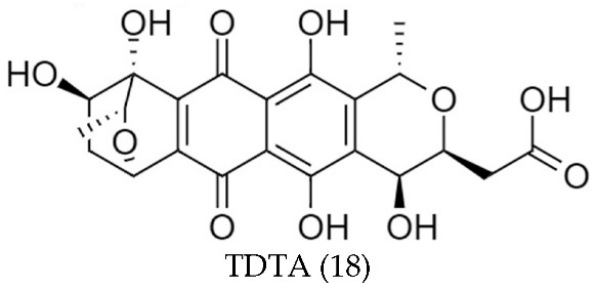
Figure 13. Chemical structures of TDTA .